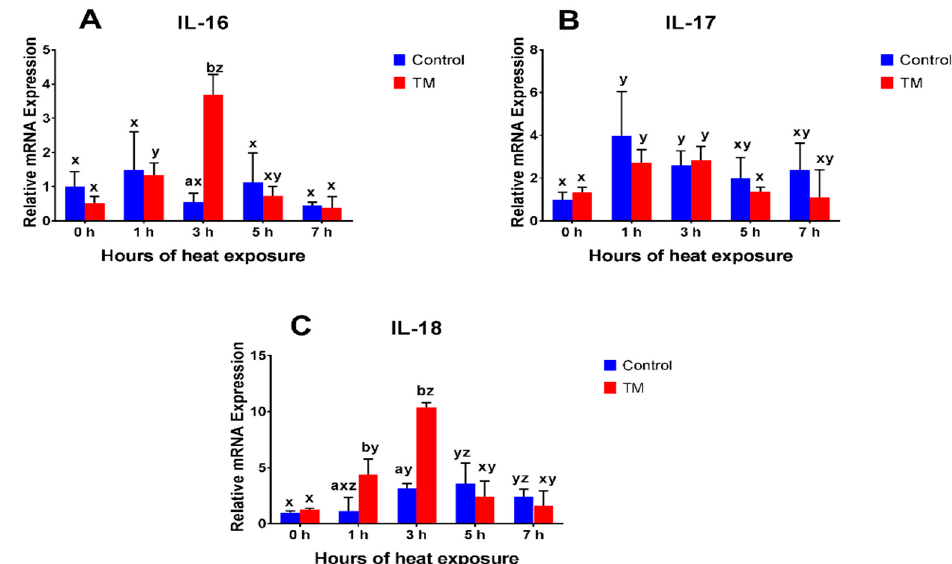
Figure 4. E ff ects of AHS at 40 ◦ C for 1, 3, 5, and 7 h on post-hatch day 28 on the splenic mRNA levels of ( A ) IL-16, ( B ) IL-17, and ( C ) IL-18 in broiler chickens subjected to TM ( n = 5). The values in the chart indicate folds of mRNA levels compared to the control groups at 0 h before AHS. a,b Within the same point of time, values ± SD of TM and control groups with di ff erent superscripts are significantly di ff erent ( p < 0.05). x–z Within the same treatment group and between di ff erent points of time, values ± SD with di ff erent superscripts are significantly di ff erent ( p < 0.05).